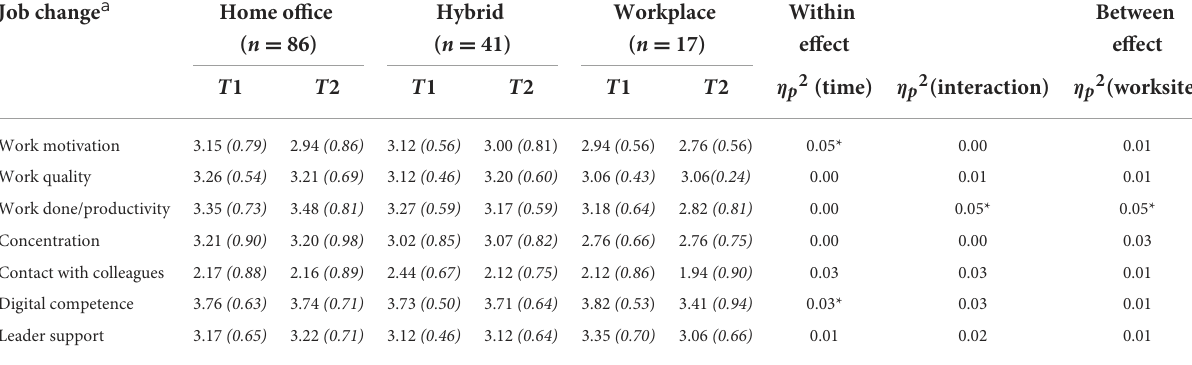
TABLE 5 Means, standard deviations (in italics), and results of repeated measures analyses of variance (MANOVAs) for study variables (evaluation of change due to COVID-19) at time 1 (T1) time 2 (T2) measurement occasion comparing employees having home office, hybrid, or workplace of the employees and who filled in both T1 and